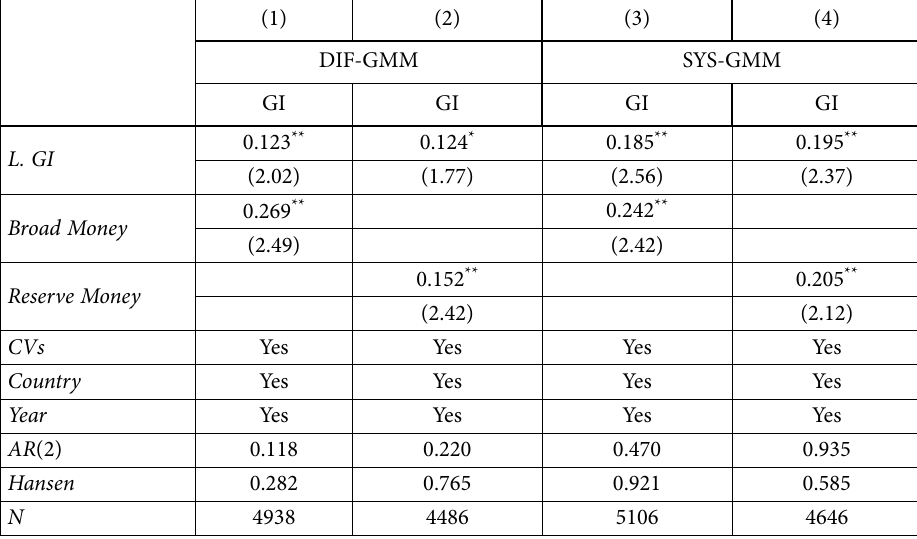
Table 7. Dynamic model and endogeneity